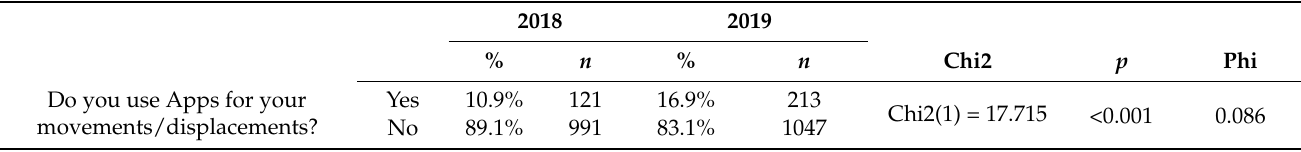
Table 4. Level of use of applications for mobility.